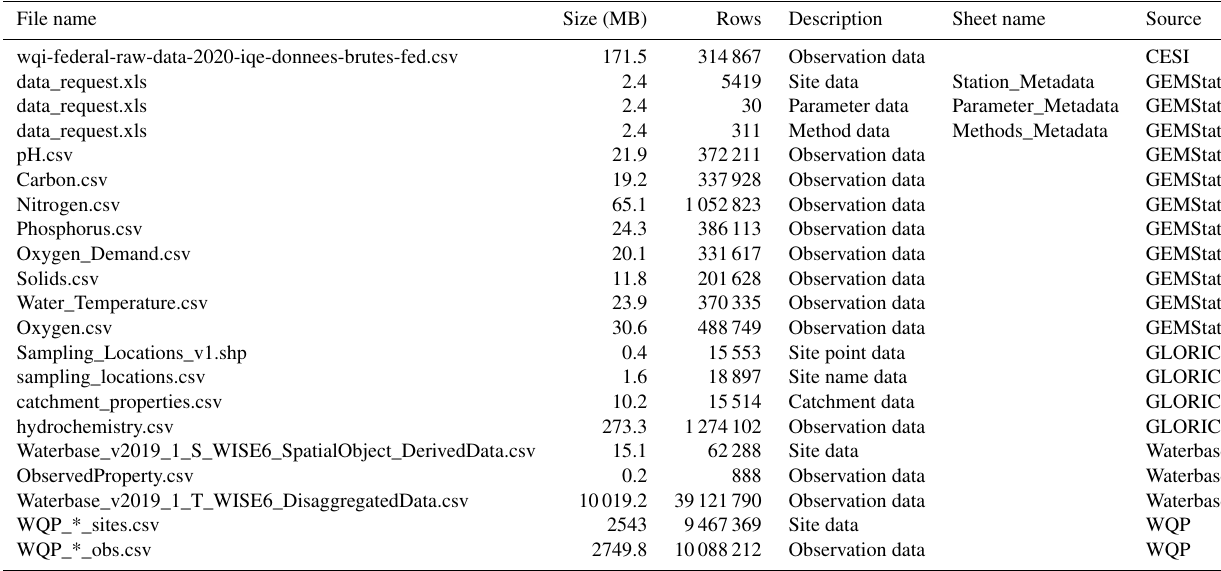
Table 2. Source dataset files used for compiling GRQA. WQP sites and observations were downloaded separately for each parameter, and file names were assigned during the